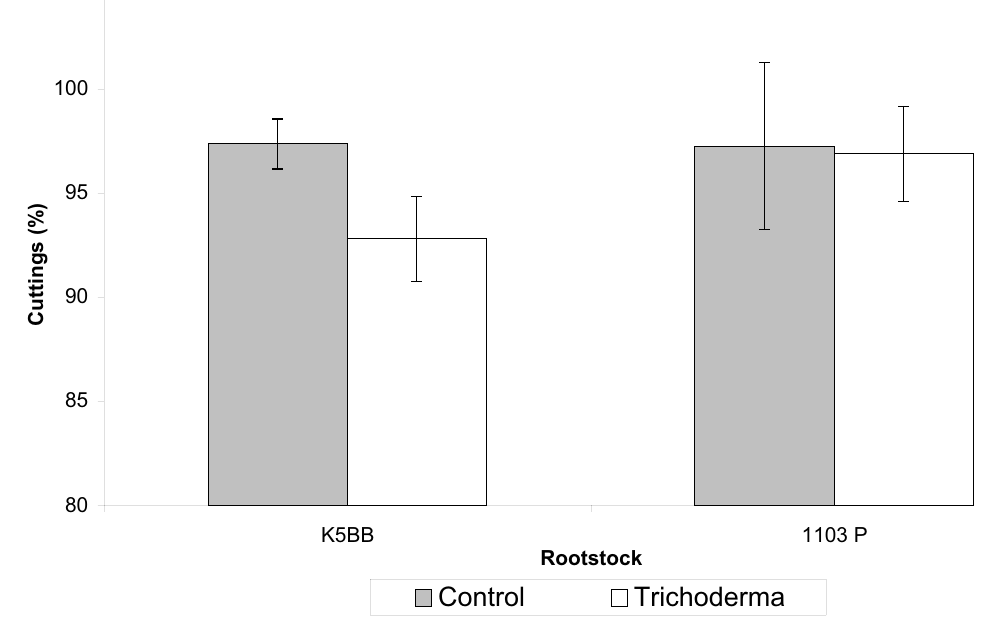
Fig. 1. Mean percentage of plantable Trebbiano romagnolo cuttings on 1103P or K5BB at the end of the callusing period, 28 weeks after Trichoderma application. Bars represent standard